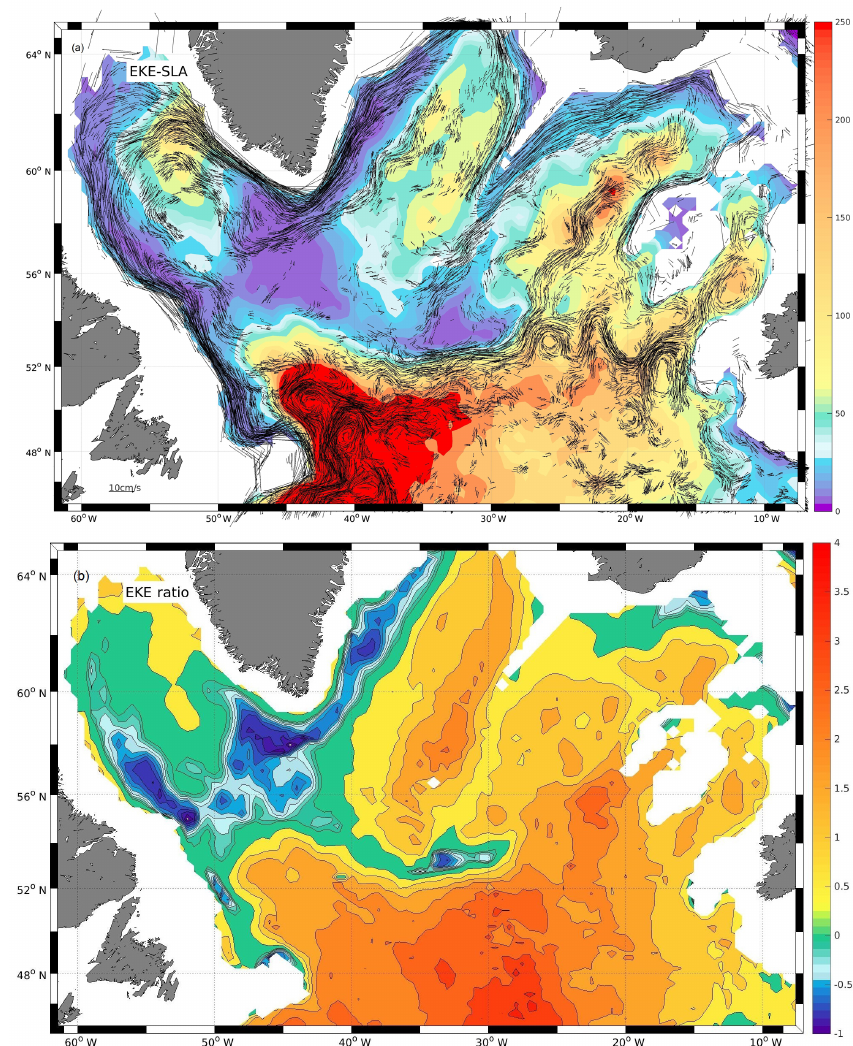
Figure 8. (a) Surface EKE derived from the AVISO geostrophic surface flow that is high-pass filtered at 180-day cut-off (in cm 2 s − 2 ) as an estimate of the geostrophic turbulence. Overlaid is the Argo-derived mean (PV-related) flow at 1000–1500m depth, with flow speeds below 1.5cms − 1 omitted; this better reveals the major advective pathways. (b) The logarithmic ratio of surface EKE to deep EKE; green and blue colors show areas in which the deep EKE